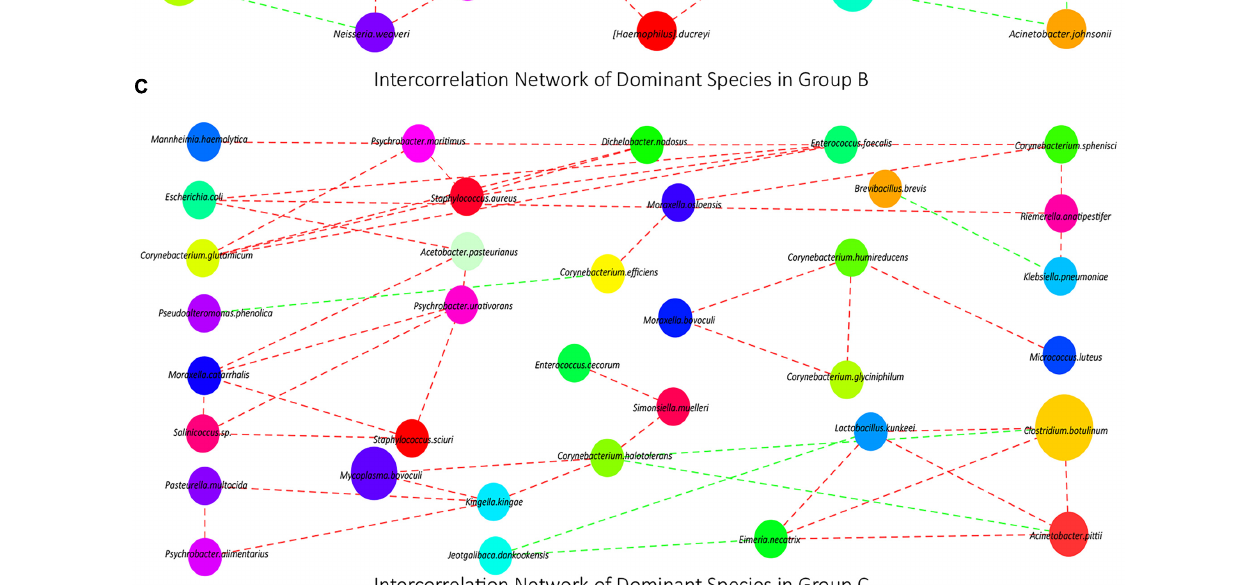
Frontiers in Microbiology |